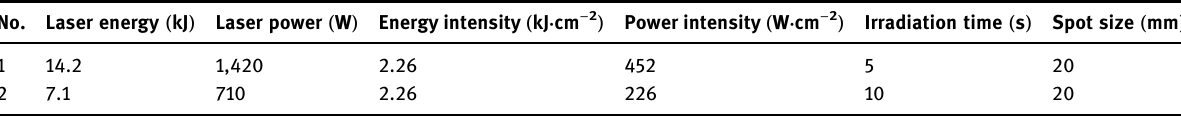
Table 1: Experimental laser